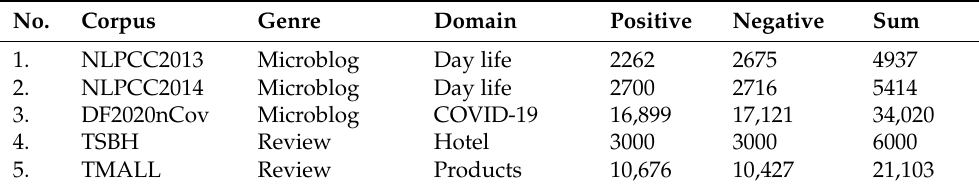
Table 1. The sentiment distribution of the adopted Chinese